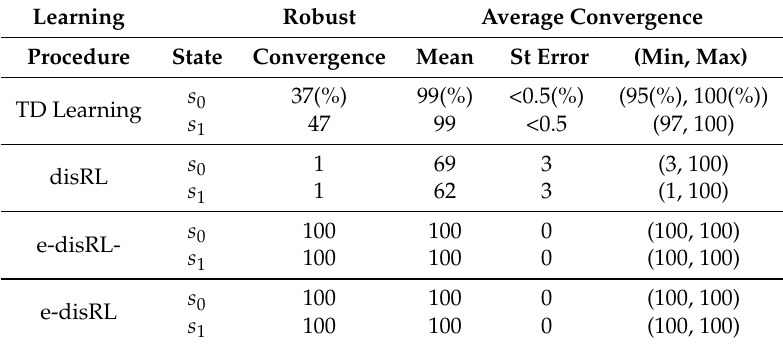
Table 4. Performance against the S&P 500 daily return distribution: Details. Robust Convergence: Percentage of 100 game plays the agent reports the optimal policy at the end of all of episodes 11-200; averages across states are reported in Table 2. Average Convergence: Percentage of episodes in a game play where optimal policy is reported at episode end. Episodes 1-10 are excluded. Mean, St Error and Min, Max are calculated over 100 game plays.